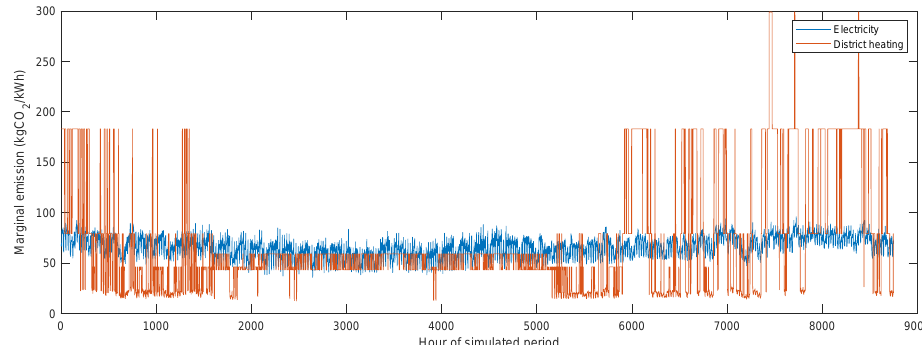
Figure A2. Marginal emissions from external electricity and district heating networks over the simulated period.